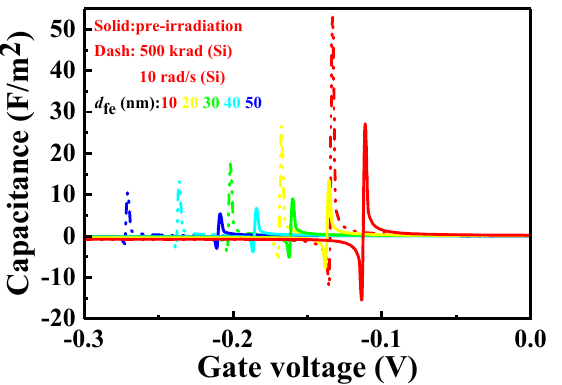
Figure 4. (Color online) Ferroelectric capacitance of MFIS-NCFET with different ferroelectric layers before irradiation and under fi xed irradiation.